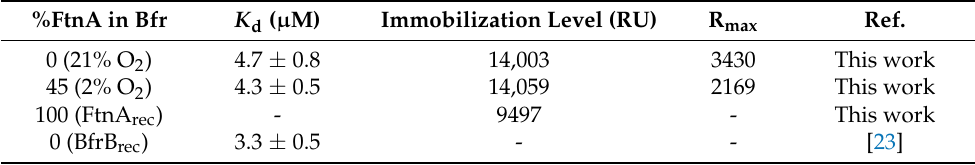
Table 2. The association between Bfd and Bfr as determined by SPR. %FtnA in